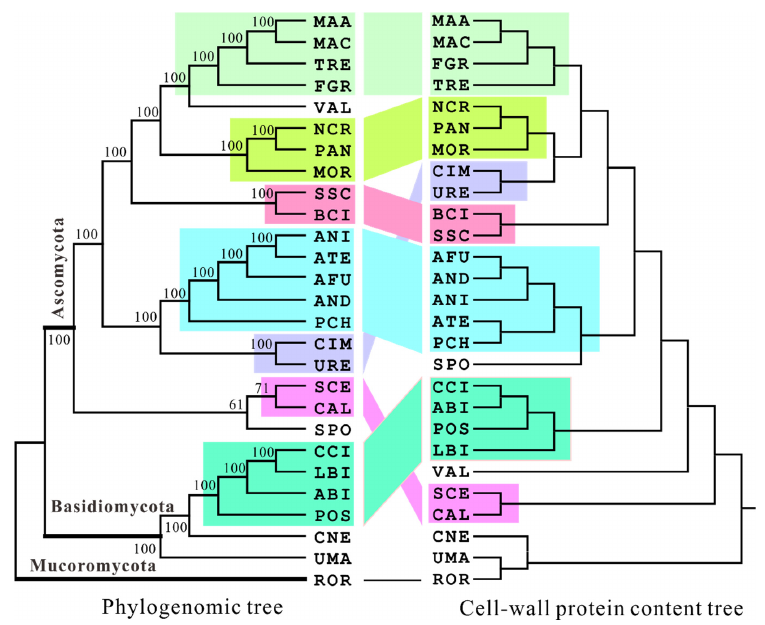
Figure 2. Cophylogenetic analysis of sequence ( left ) and cell wall protein-content-based ( right ) trees. The similar grouped lineages in both types of trees are highlighted in the same color and connected. The abbreviations of fungal species are listed in Table S1 if not mentioned in the context.